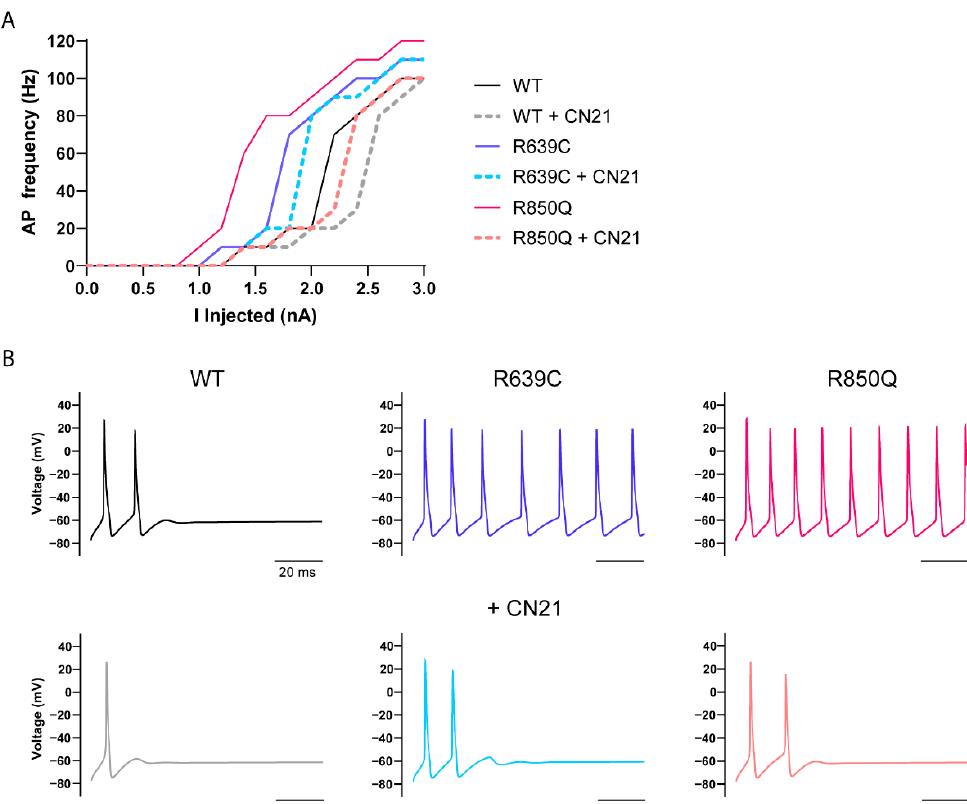
Figure 10. Simulations of action potential firing in a cortical pyramidal neuron expressing hetero- zygous mutant Nav1.6 channels with and without CaMKII inhibition. ( A ) Quantification of evoked action potential frequency from modeled cortical pyramidal neurons expressing either 100% WT Nav1.6 or 50% WT and 50% mutant Nav1.6 channels to reflect heterozygous expression (WT, black; WT + CN21, gray; R639C, blue; R639C + CN21, cyan; R850Q, red; R850Q + CN21, pink). Representa- tive traces of action potentials evoked by 1.8 nA current injection are shown in ( B ).